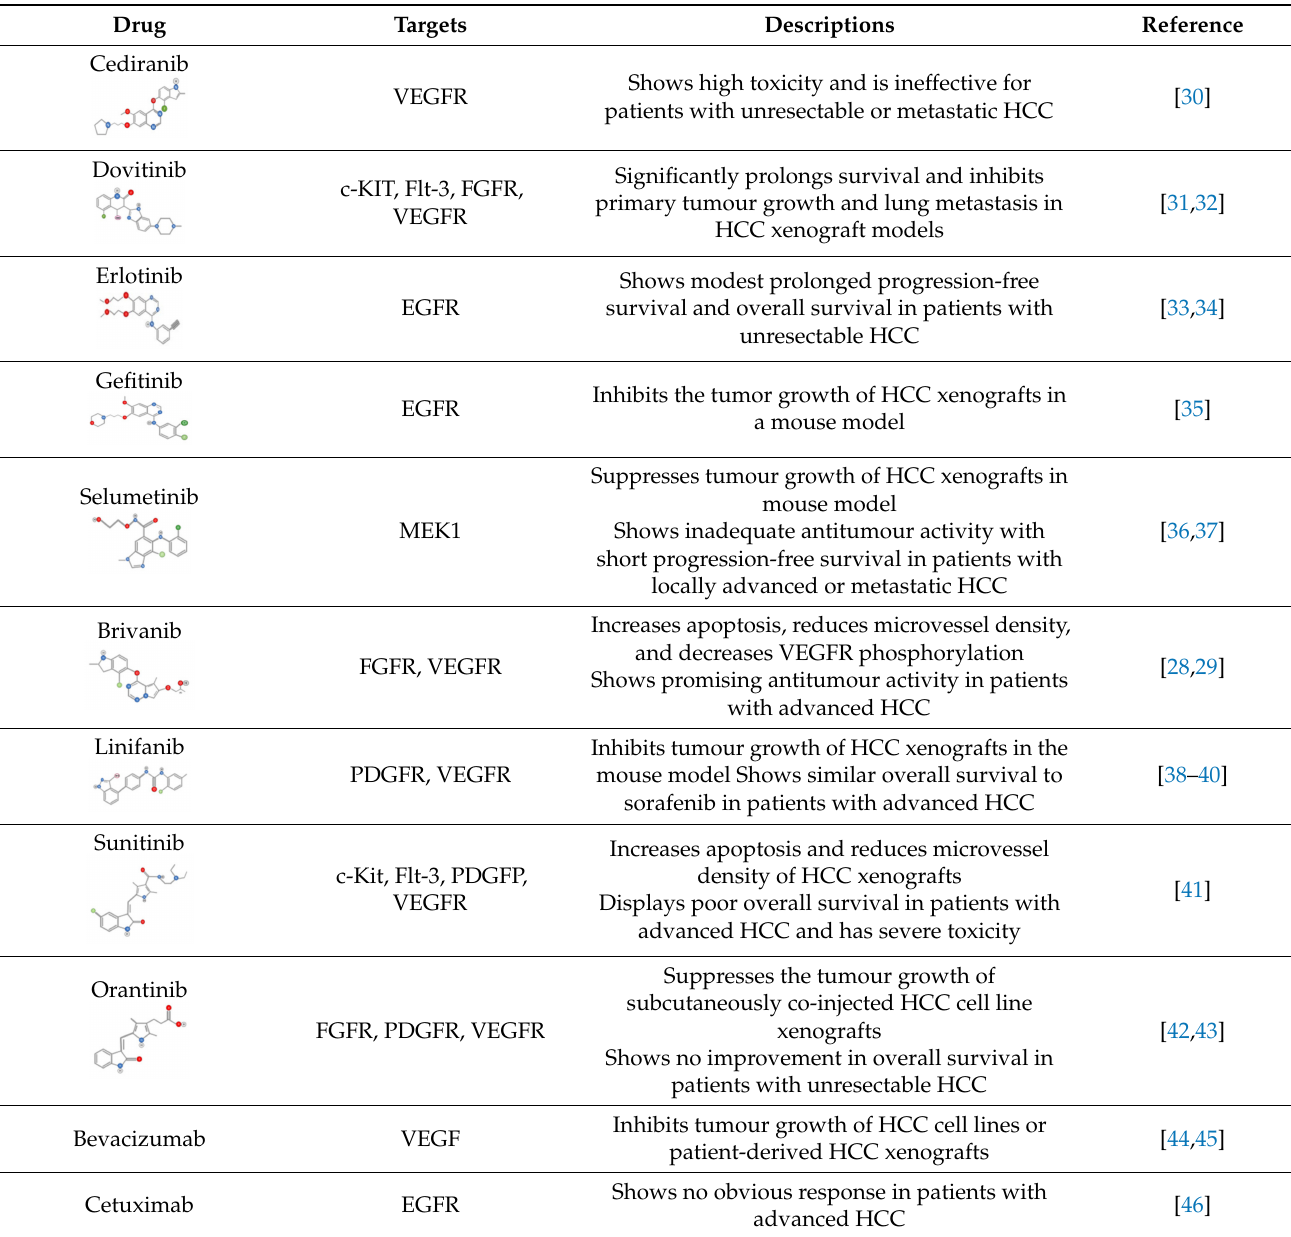
VEGF: Vascular endothelial growth factor; VEGFR: Vascular endothelial growth factor receptor; FGFR: Fibroblast growth factor receptor; EGFR: Epidermal growth factor receptor; MEK1: Mitogen-activated protein kinase (MAPK) kinase; PDGFR: Platelet-derived growth factor receptor; Flt-3: FMS-like tyrosine